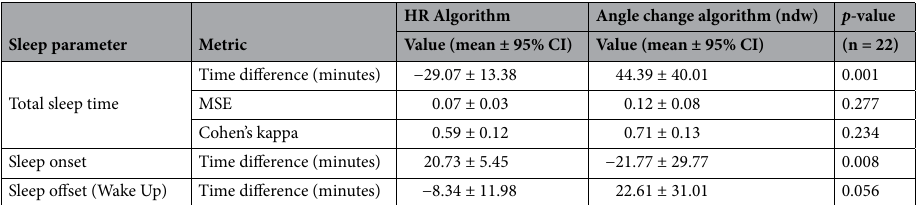
Table 7. Results for the PhysioNet Apple Watch dataset. The table presents results for both the HR and angle change algorithm for total sleep time, sleep onset and sleep offset in the PhysioNet Apple Watch dataset.